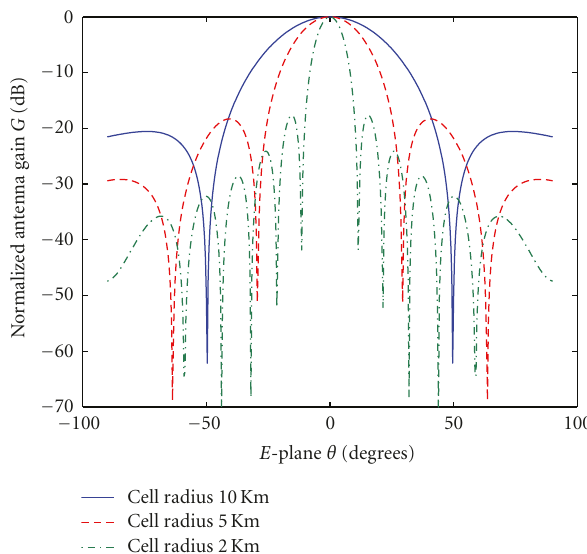
Figure 3: HAP base station antenna patterns for di ff erent cell radii.